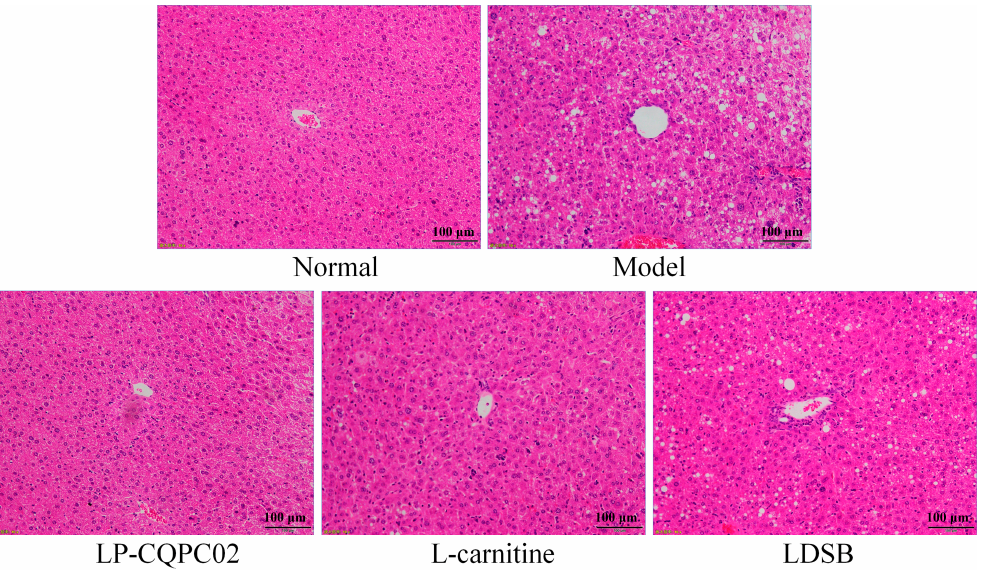
Figure 2. Hematoxylin-eosin (H&E) pathological observation of hepatic tissue in mice. Magnification 100 × . LDSB: Mice treated with 1.0 × 10 9 CFU / kg of Lactobacillus delbruechii subsp. bulgaricus ; LP-CQPC02: Mice treated with 1.0 × 10 9 CFU / kg of Lactobacillus plantarum CQPC02; l -carnitine: Mice treated with 200 mg / kg of l -carnitine.